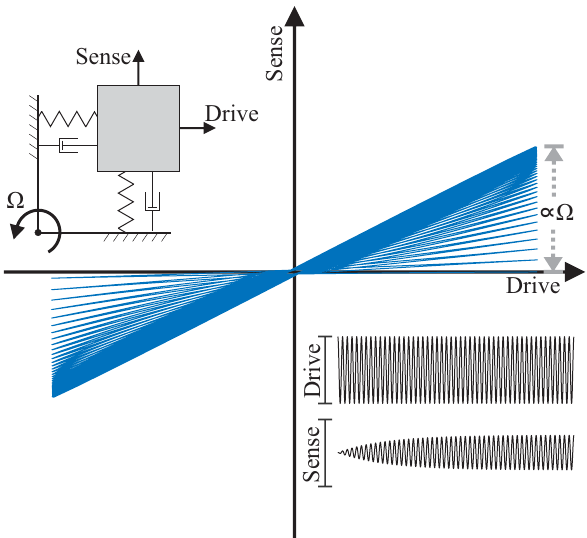
Figure 1. Response of a CVG operating in the angular rate mode. The response is due to rotation along the Z-axis, orthogonal to the page. Overlay plot of drive and sense axes oscillations illustrates a harmonic motion along the drive axis and transients along the sense axis, with the steady-state amplitude along the sense axis proportional to the applied angular rate.